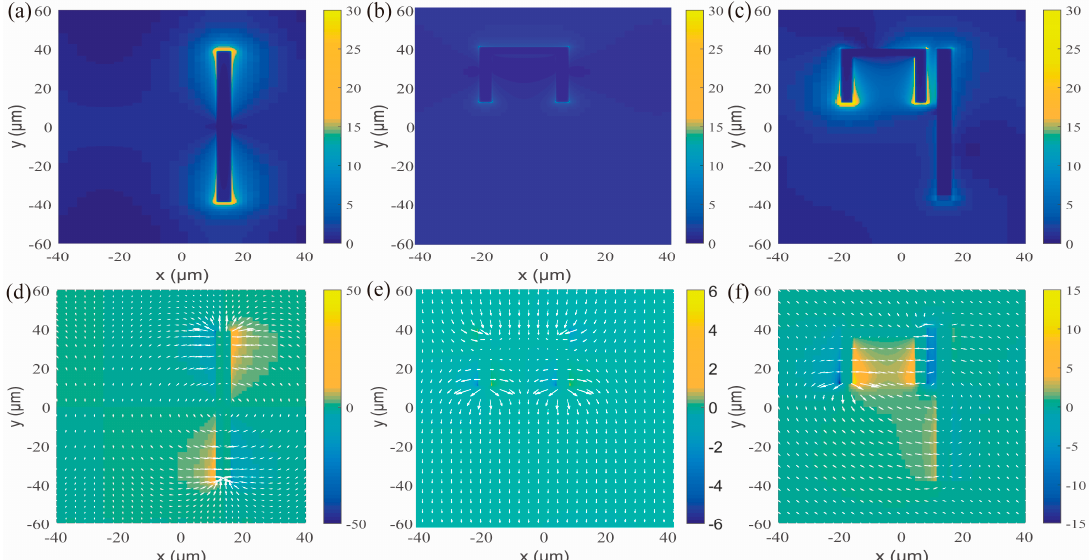
Figure 3. x-component of electric field and electric field vector size and direction of ( a ) the bright mode resonator ( b ) the dark mode resonator and ( c ) the combined EIT analogue structure. The magnitude of electric field of ( d ) the bright mode resonator ( e ) the dark mode resonator and ( f ) the EIT analogue structure. All of the above are the results of illumination of an incident plane wave at a frequency of 1.6 THz.